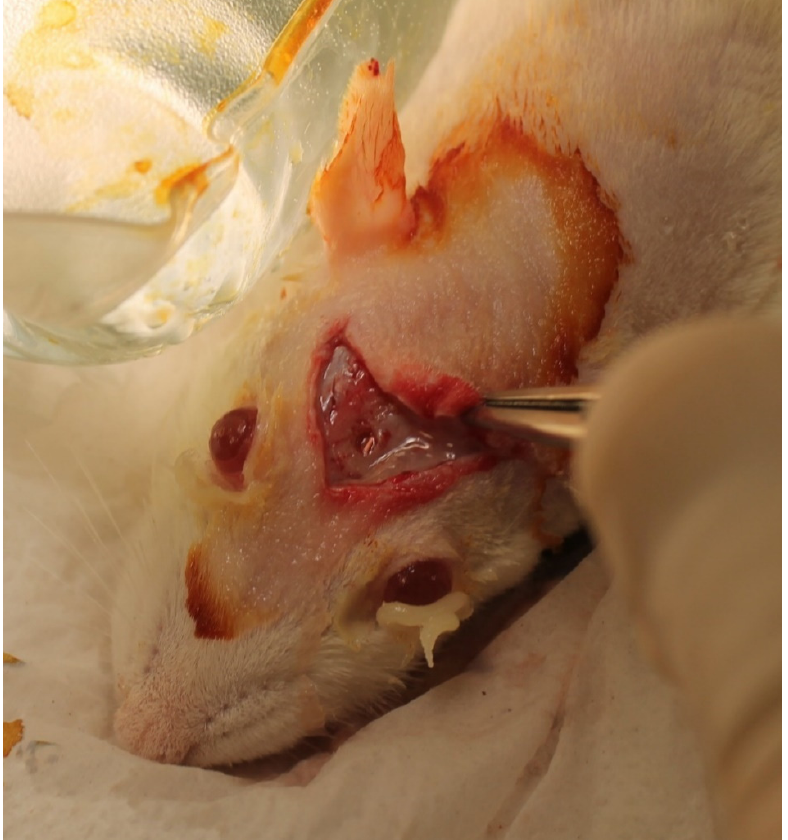
Figure 3. Intra-operative view of the rat caldarium operation.